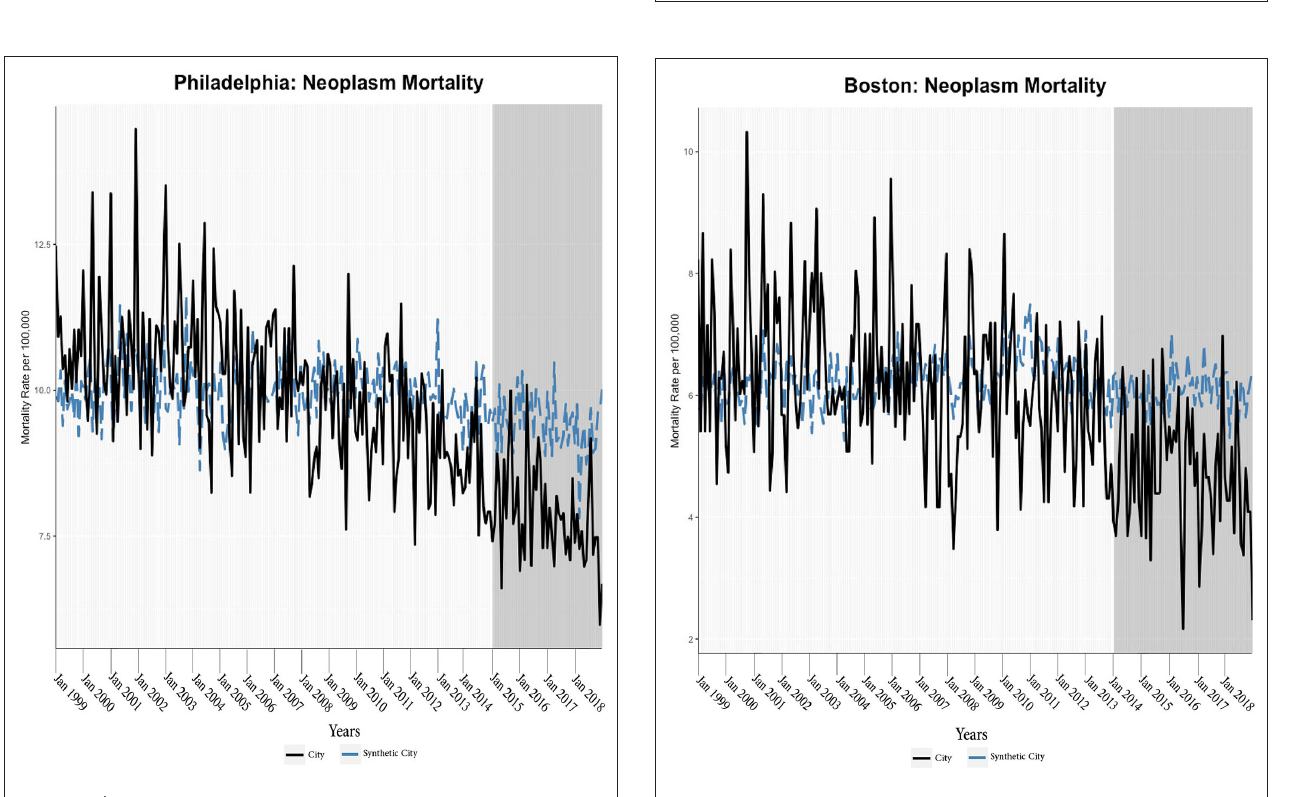
FIGURE 10 | Neoplasm mortality trends: Boston and synthetic control